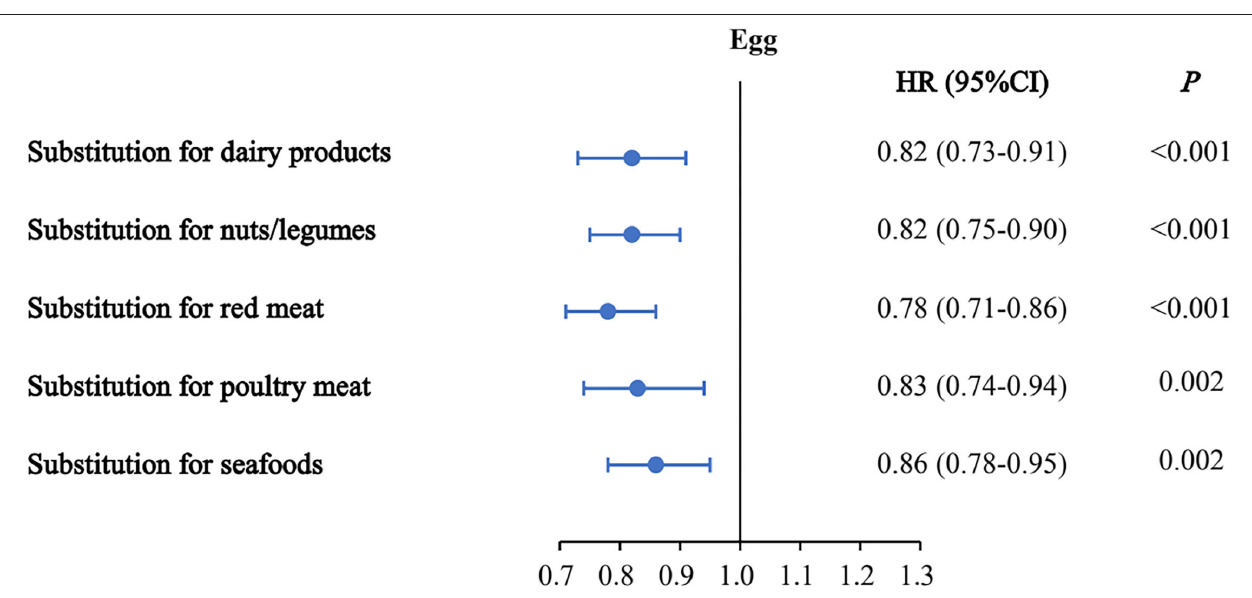
FIGURE 1 | Multivariable hazard ratios (HRs) of mortality by substitution of 50 g/d eggs for the equivalent amount of other protein sources. Forest plots show the multivariable HRs of mortality associated with substituting 50 g/d eggs for equivalent amounts of dairy products, nuts/legumes, red meat, poultry, or seafood. HRs were adjusted for nationality, marital status, body mass index, income, urbanization index, education, smoking, alcohol use, history of cardiovascular disease, cancer, and diabetes, intake of total energy, cereal, potato, dairy product, nut/legume, sodium, red meat, white meat, SSB, vegetables, and fruits at the baseline. Horizontal lines represent 95%